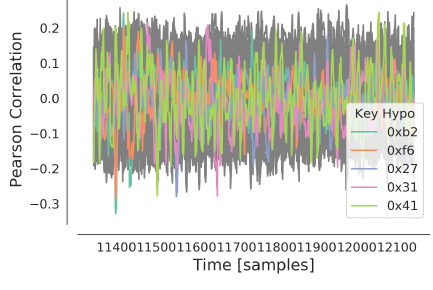
Figure 34: Pearson Correlation coefficients in Step 3 (byte 0) with 256 traces.